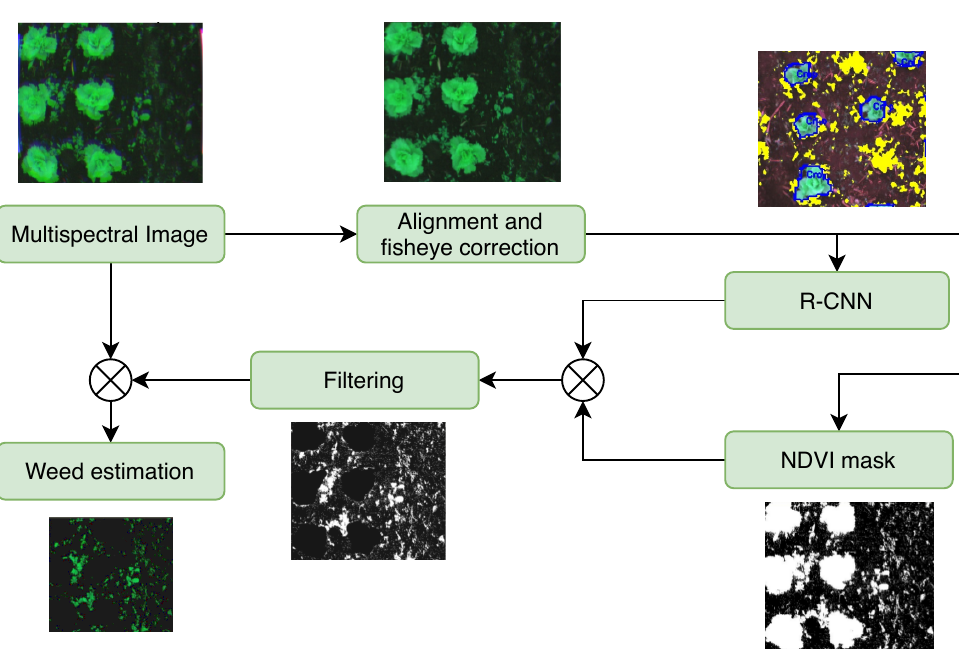
Figure 6. A diagram of method 3 based on RCNN (region convolutional neural network), using masks for contour detection: it shows the sequence for preparation, crop-weed detection, and segmentation using an NDVI mask for weed coverage